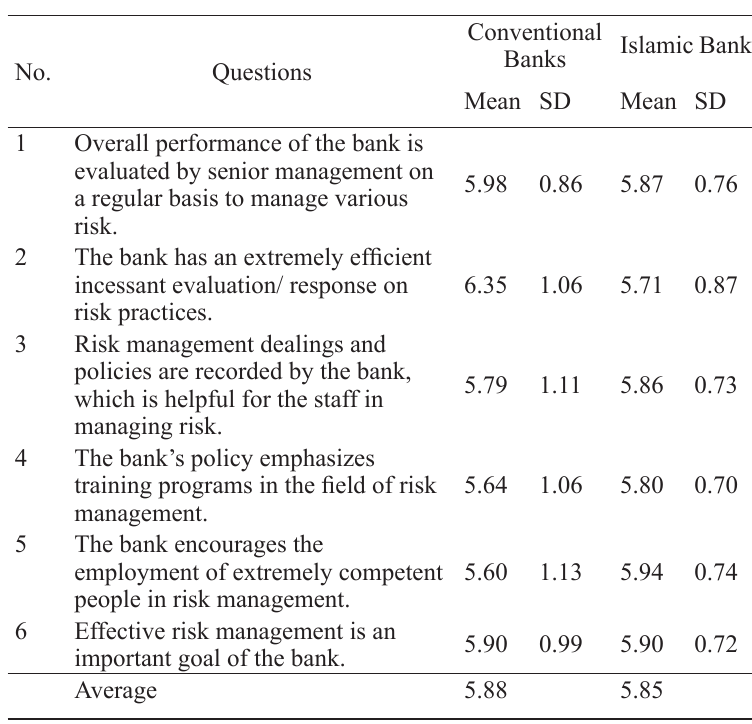
Responses to Questions about the